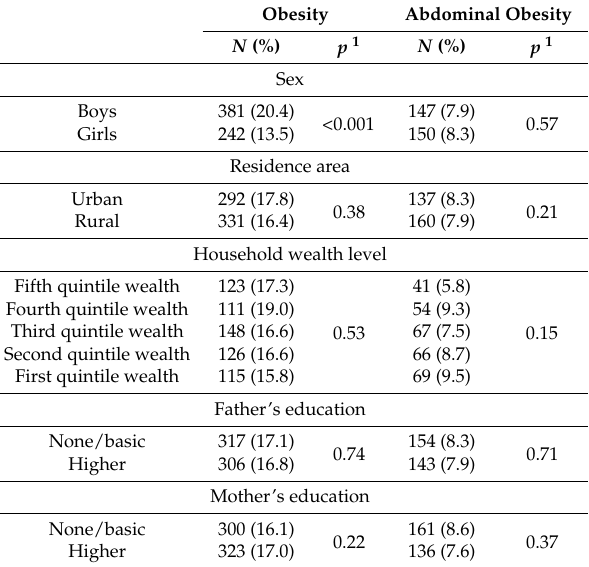
Table 4. Prevalence of childhood obesity by